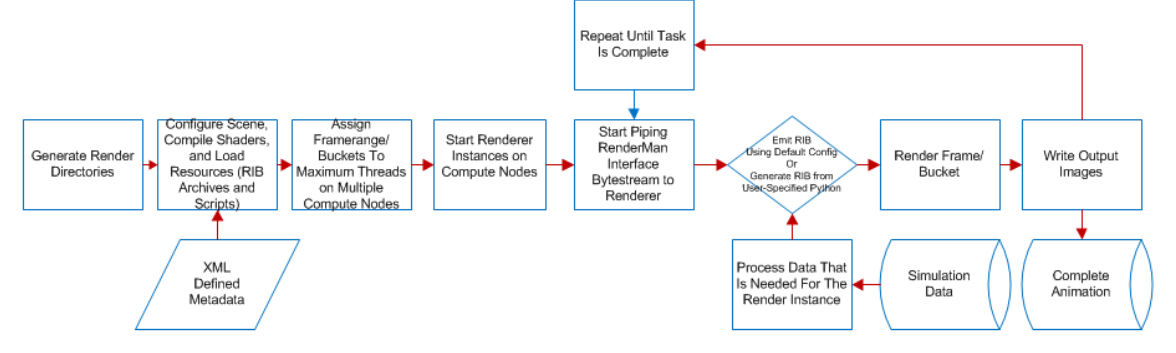
Figure 23. Chrono ::Render execution workflow. Figure 23 : Chrono ::Render execution workflow. Figure 22 : An overview of the REYES Pipeline.